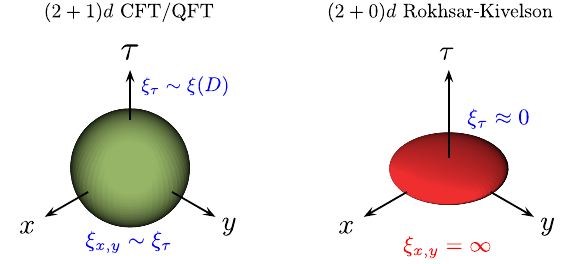
FIG. 9. Illustration of the space-time volume sampled in a ð 2 þ 1 Þ d iPEPS for CFTs or quantum field theories (QFTs) versus the ð 2 þ 0 Þ d Rokhsar-Kivelson-type iPEPS wave